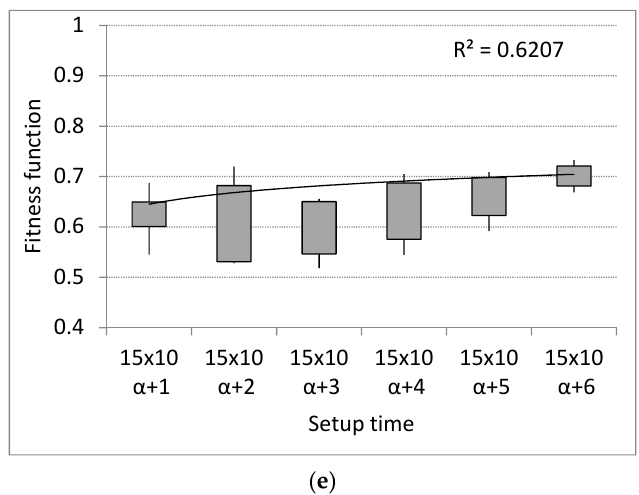
Figure 17. The influence of setup time α on ( a ) makespan, ( b ) cost of energy consumption, ( c ) cost of tardiness or premature execution, ( d ) total delay of tasks, ( e ) scalar fitness function for the serial–parallel flow for scheduling problem 15 × 10.